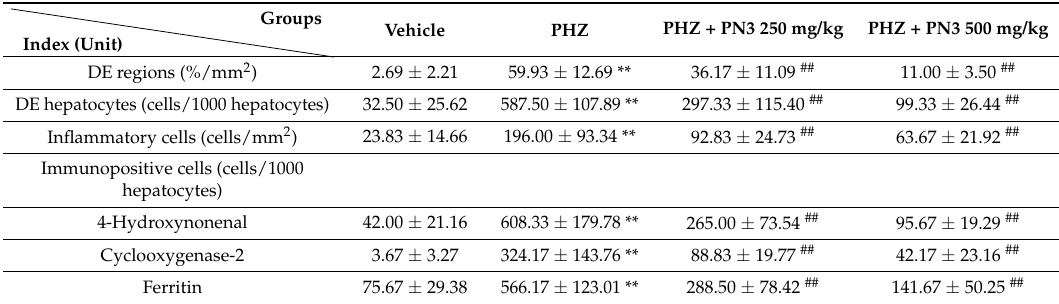
Table 1. Histomorphometrical analysis of hepatic tissues, taken form vehicle or PHZ-treated mice.